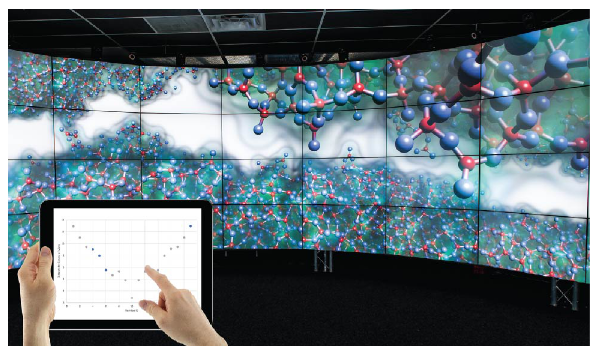
Figure 9: Platform illustration in a hybrid environment made of a 3D immersive CAVE2 system (EVL/UIC, Chicago) to- gether with a graphical tablet for 2D analytical representation.